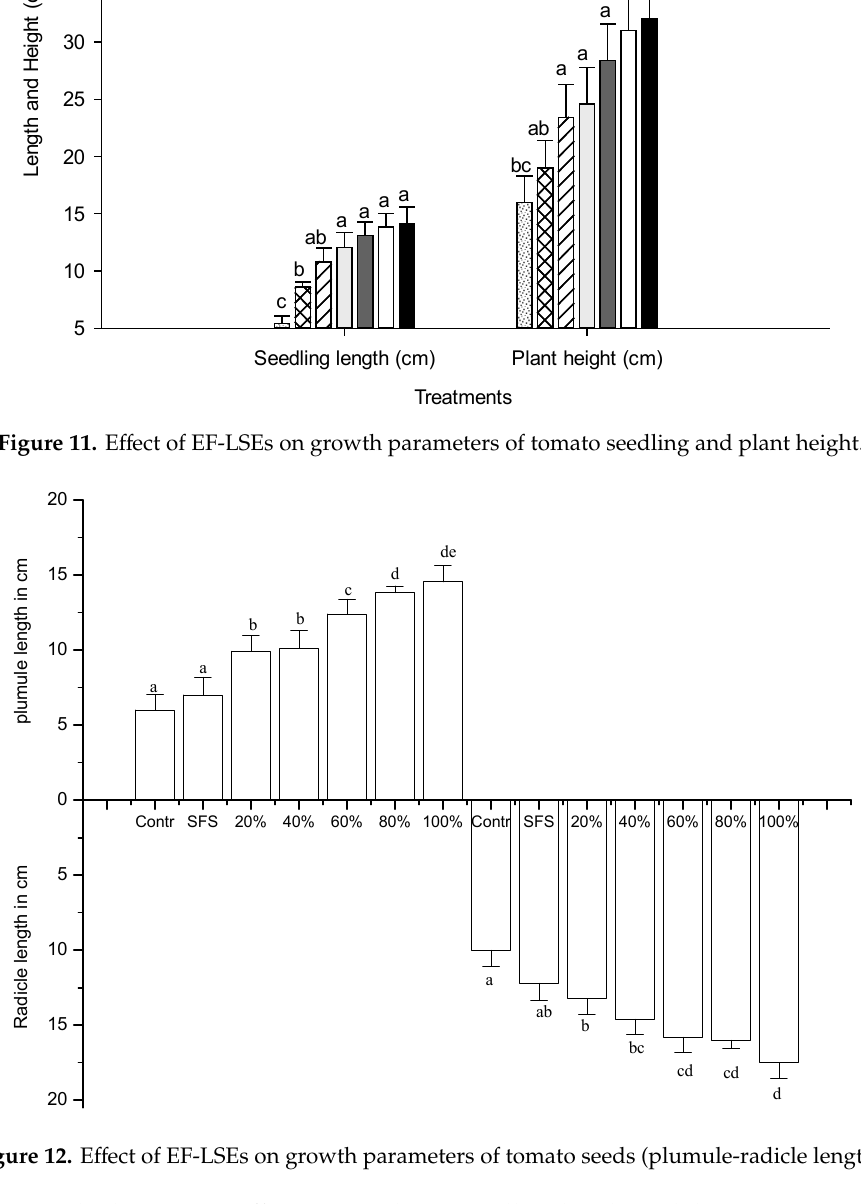
Figure 12. E ff ect of EF-LSEs on growth parameters of tomato seeds (plumule-radicle length). The EF-LSEs had a positive e ff ect in stimulating seedling height and their respective radicle and plumule lengths to 10.8 cm ( F 6,28 = 30.98; p < 0.005), 5.12 cm ( F 6,28 = 42.16; p < 0.005) and 4.12 cm ( F 6,28 = 42.94; p < 0.005), respectively, at 20% concentration, exhibiting radicle: plumule ratio of 1.36 cm ( F 5,24 = 32.20, p < 0.005). Similarly, the 40% EF-LSE treated seeds exhibited respective seedling height, radicle and plumule lengths, radicle: plumule ratio of 12.07 cm ( F 6,28 = 30.98; p < 0.005), 5.72 cm ( F 6,28 = 42.16; p < 0.005) and 5 cm ( F 6,28 = 42.94; p < 0.005) and 1.59 ( F 5,24 = 32.20, p < 0.005). Likewise 60% and 80% EF-LSE treated seeds were observed with seedling lengths of 13.09 cm and 13.84 cm ( F 6,28 = 30.98; p < 0.005), with corresponding radicle and plumule lengths of 7.6 cm ( F 6,28 = 42.16; p < 0.005) and 5.8 cm ( F 6,28 = 42.94; p < 0.005) as well as 8.2 cm ( F 6,28 = 42.16; p < 0.005) and 6.4